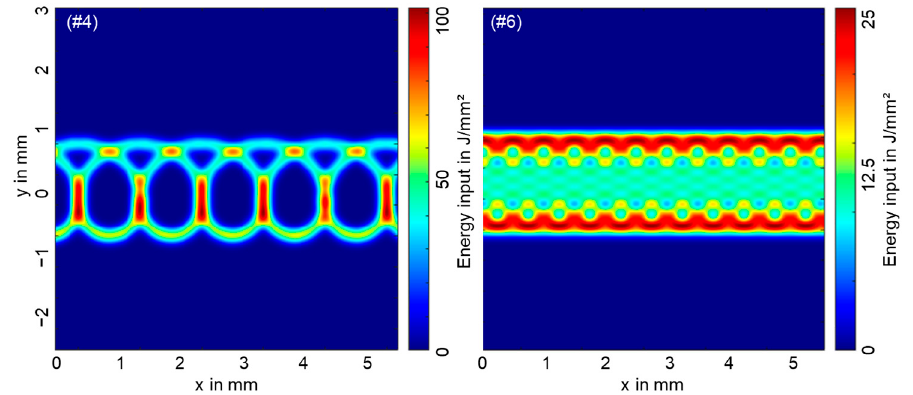
Figure 11. Distribution of the local energy input by spatial power modulation with a circular oscillating beam, P L = 1500 W, v F = 150 mm/s, f = 150 Hz (#4, left ) and by a vertical eight oscillation strategy with P L = 800 W, v F = 25 mm/s, f = 100 Hz (#6, right ).